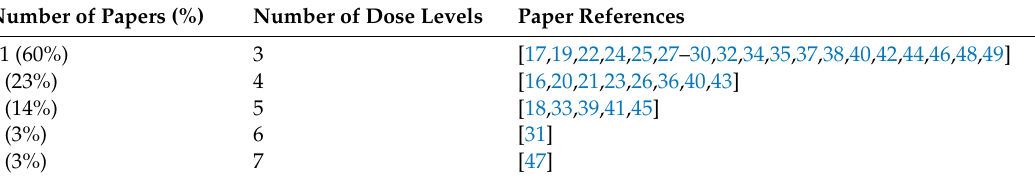
Table 4. The number and percentage of papers containing studies at each number of dosing levels. Number of Papers